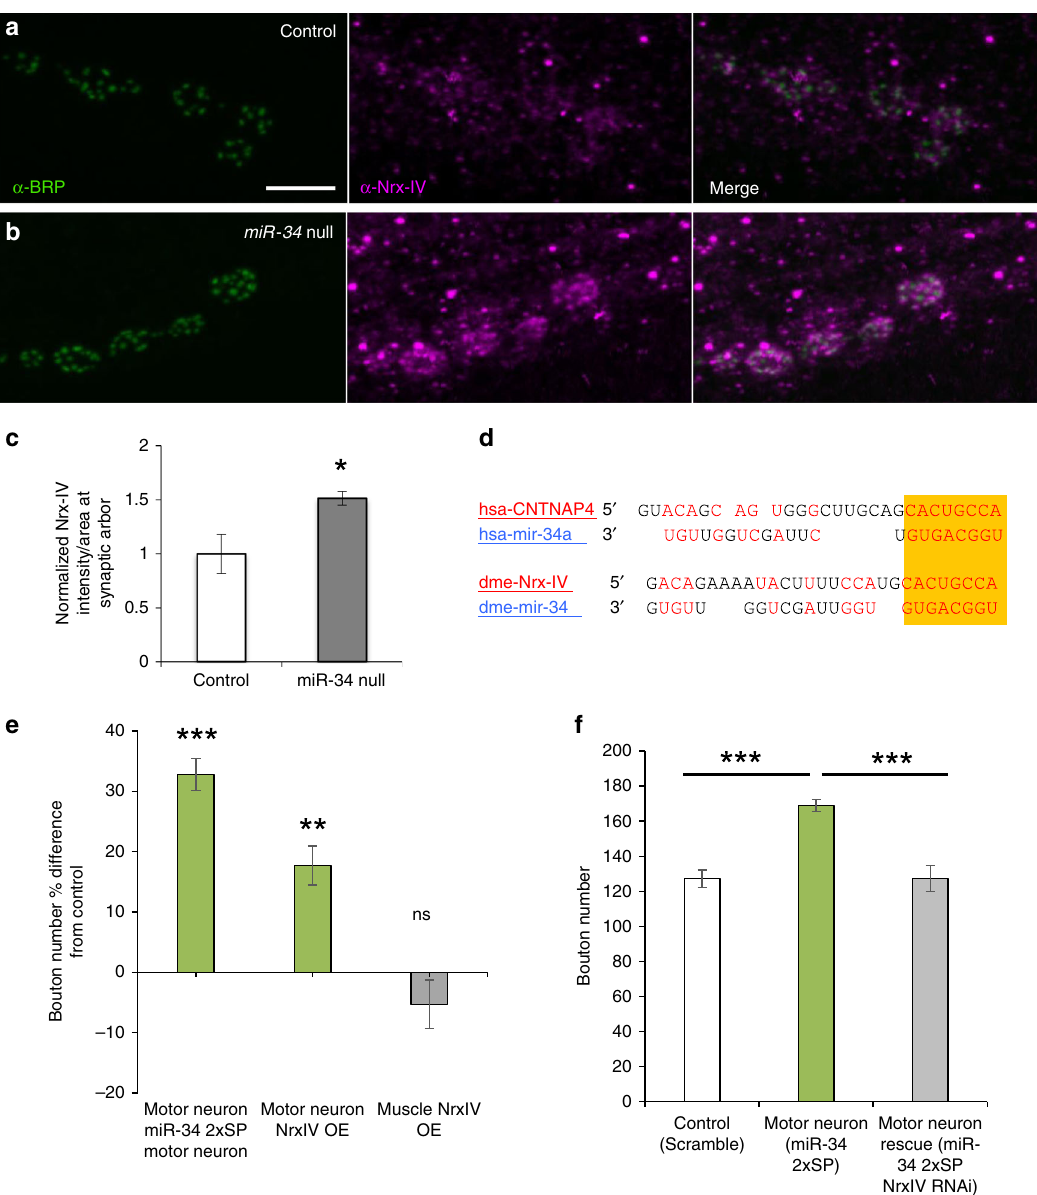
Fig. 4 Restriction of synaptic Nrx-IV protein can account for motor neuron inhibition of miR-34 . a , b Presynaptic active zones marked by the T-bar constituent Brp (green) are surrounded by small punctate accumulations of Nrx-IV protein (magenta) in the terminal boutons of the M6/7NMJ (segment A2; Scale bar: 5 µ m). b In miR-34 null animals, an identical staining and imaging protocol reveals a consistent and signi fi cant increase in the size and intensity of Nrx-IV puncta compared to control in a . c The difference in intensity between synaptic Nrx-IV signals is quanti fi ed ( n = 6 NMJs per genotype; * p -value ≤ 0.05). d Alignment of the conserved MRE for Human (hsa) miR-34a within the 3 ’ UTR of CNTNAP4 is shown in comparison to the corresponding MRE for Drosophila (dme) miR-34 in the Neurexin-IV (Nrx-IV) mRNA. e Motor neuron-speci fi c competitive inhibition of miR-34 ( n = 21) using OK6-GAL4 to express miR-34SP is compared to Nrx-IV overexpression (Nrx-IV OE) of under OK6-GAL4 (green bar; n = 19) or a muscle-speci fi c DMef2-GAL4 (gray bar; n = 20) (** p -value ≤ 0.01; *** p -value ≤ 0.001) all relative controls n = 20. f OK6-GAL4 expression of miR-34SP induces a signi fi cant increase in type 1 bouton numbers per NMJ (green bar; n = 20) compared to Scramble-SP controls (white bar; n = 21); this phenotype is completely rescued by co-expression of UAS-Nrx-IV RNAi (gray bar; n = 20) (*** p -value ≤ 0.001). Source data are provided as a Source Data fi